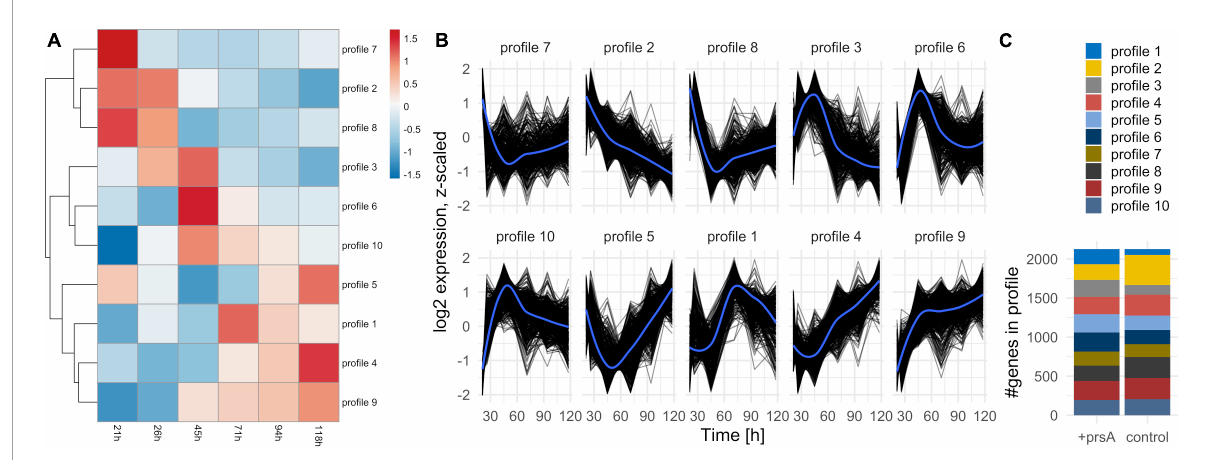
FIGURE2 Expression profiles. (A) Heatmap of the expression profile over time (columns) for all differentially expressed coding and non-coding annotations investigated separately per strain. The resulting profiles were clustered (rows) and re-arranged by a complete linkage tree. (B) Profiles of expression per cluster for each annotation (black lines). An overall average expression according to a loess regression is added in blue. (C) The number of annotations per profile in either strain. The expression dynamics for each annotation can be in two separate profiles in the